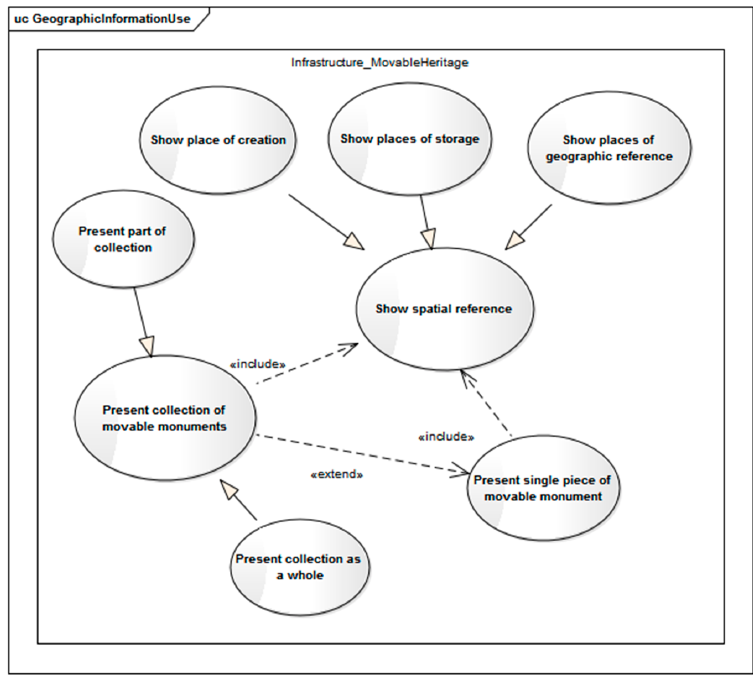
Figure 7. Presentation of different spatial relations of monuments (source: own work).